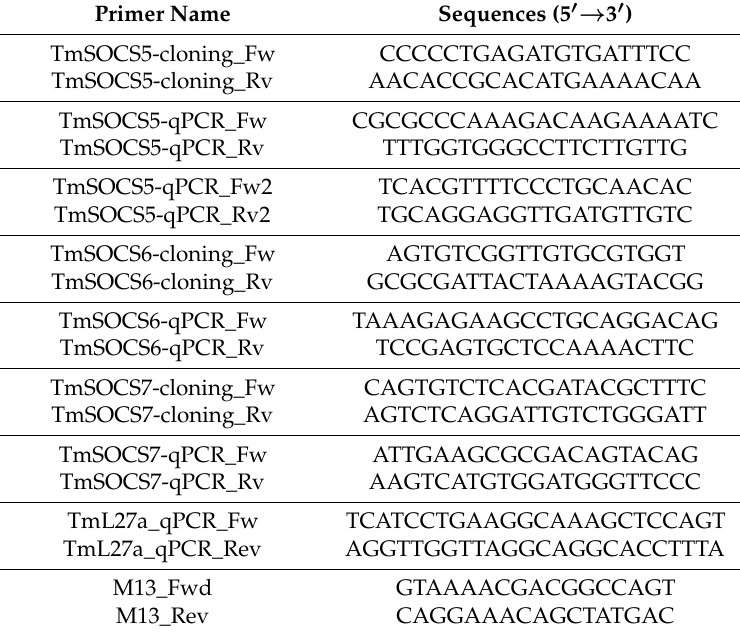
Table 1. Primers used in this